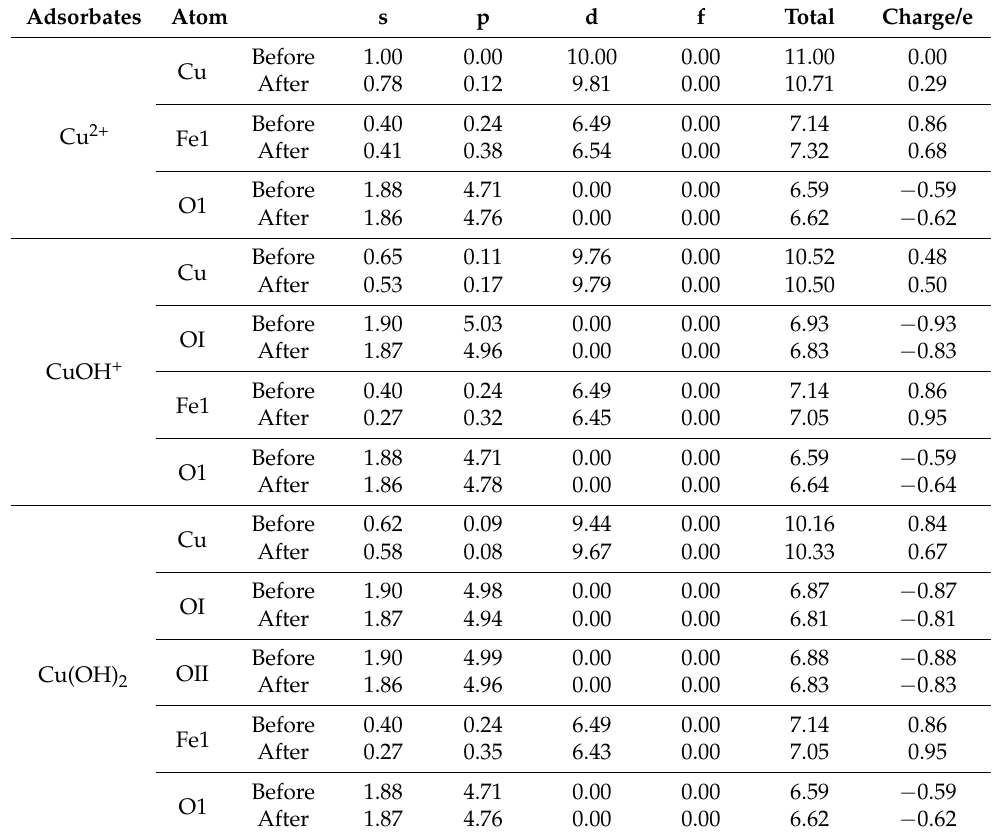
Table 4. Mulliken charge populations of bonding atoms before and after different Cu species